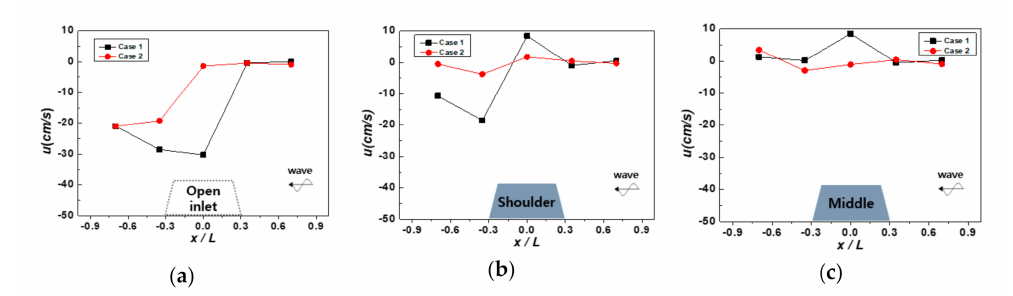
Figure 6. Average flow rate distribution ( U bottom ) by structure type (Case 1: dolos; Case 2: hybrid (dolos with the coral reef)): average flow rate at ( a ) the open inlet, ( b ) the shoulder of the structure, and ( c ) the middle of the